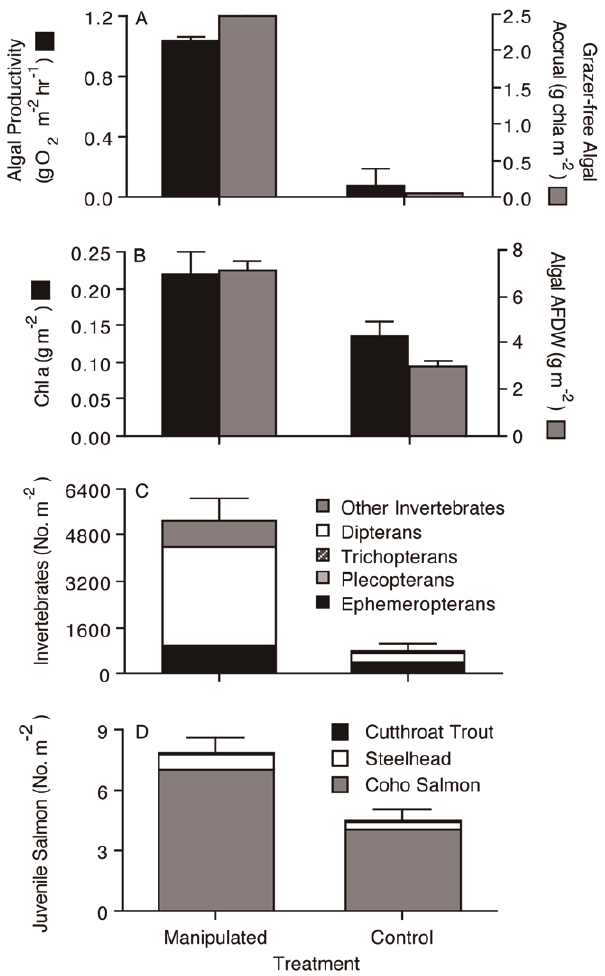
Figure 2. Biological responses to riparian manipulations (mean ± 1 se). (A) Algal productivity, based on light-dark oxygen production (black bars) and grazer-free algal chlorophyll a accrual (gray bars). (B) Algal standing crop estimated from either ash-free dry mass (gray bars) or chlorophyll a (black bars). (C) Aquatic invertebrate densities. (D) Juvenile salmonid densities, distinguished by species.